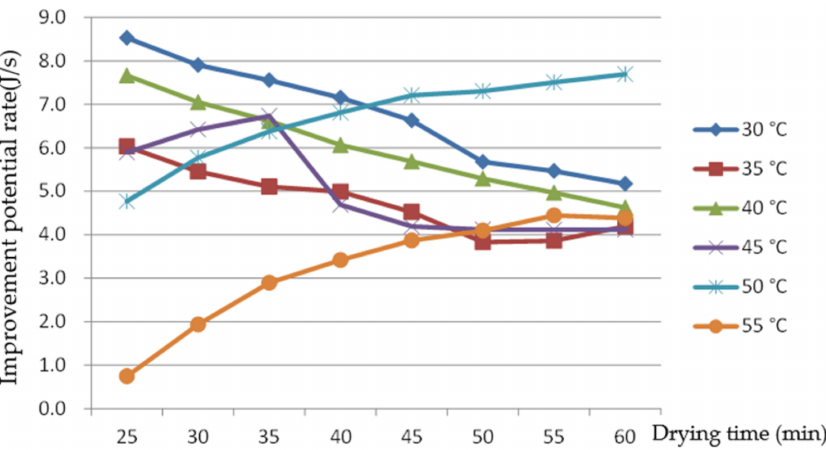
Figure 10. The improvement potential rate changes with drying time at different air